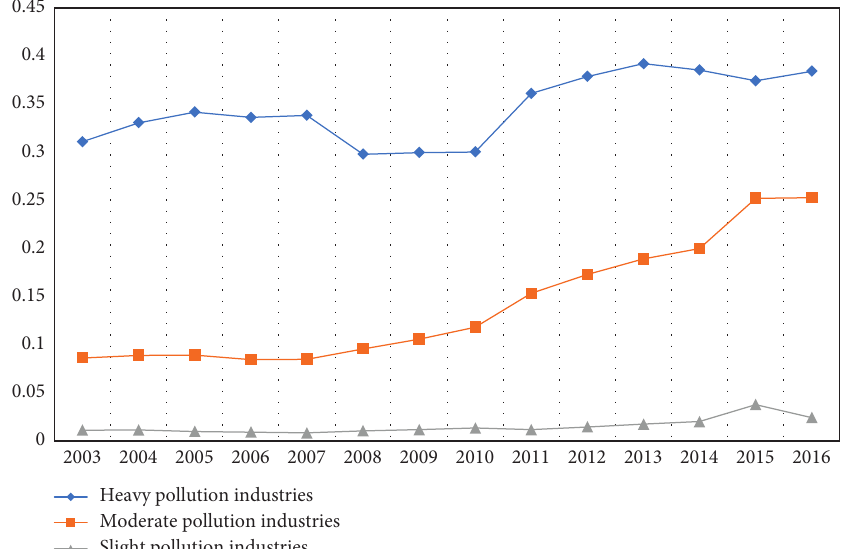
Figure 3: Changes in the intensity of environmental regulations in the three major categories of